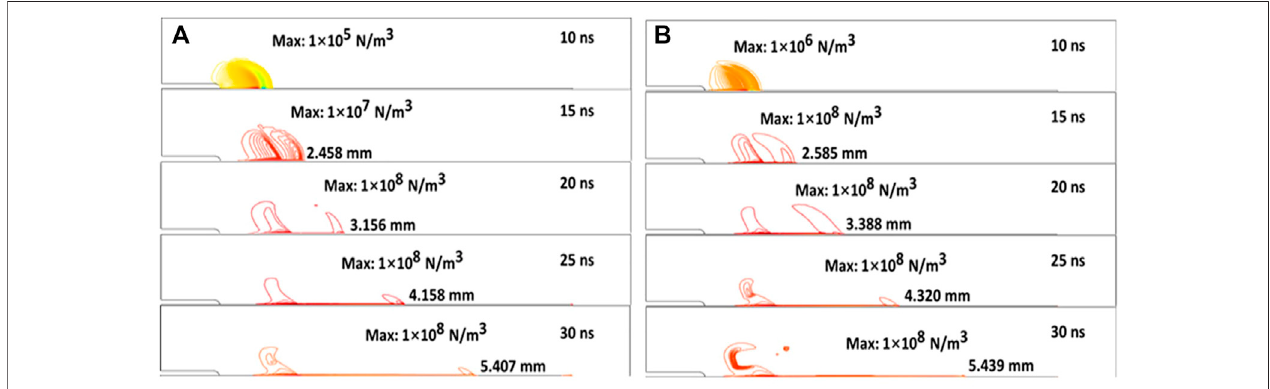
FIGURE 10 | Contours of momentum source with dielectric barrier of uniform permittivity (A) and graded permittivity (B) .